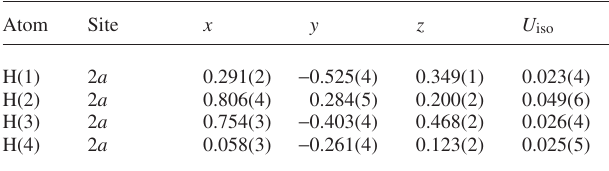
Table 2. Atomic coordinates and displacement parameters (in Å 2 ) .